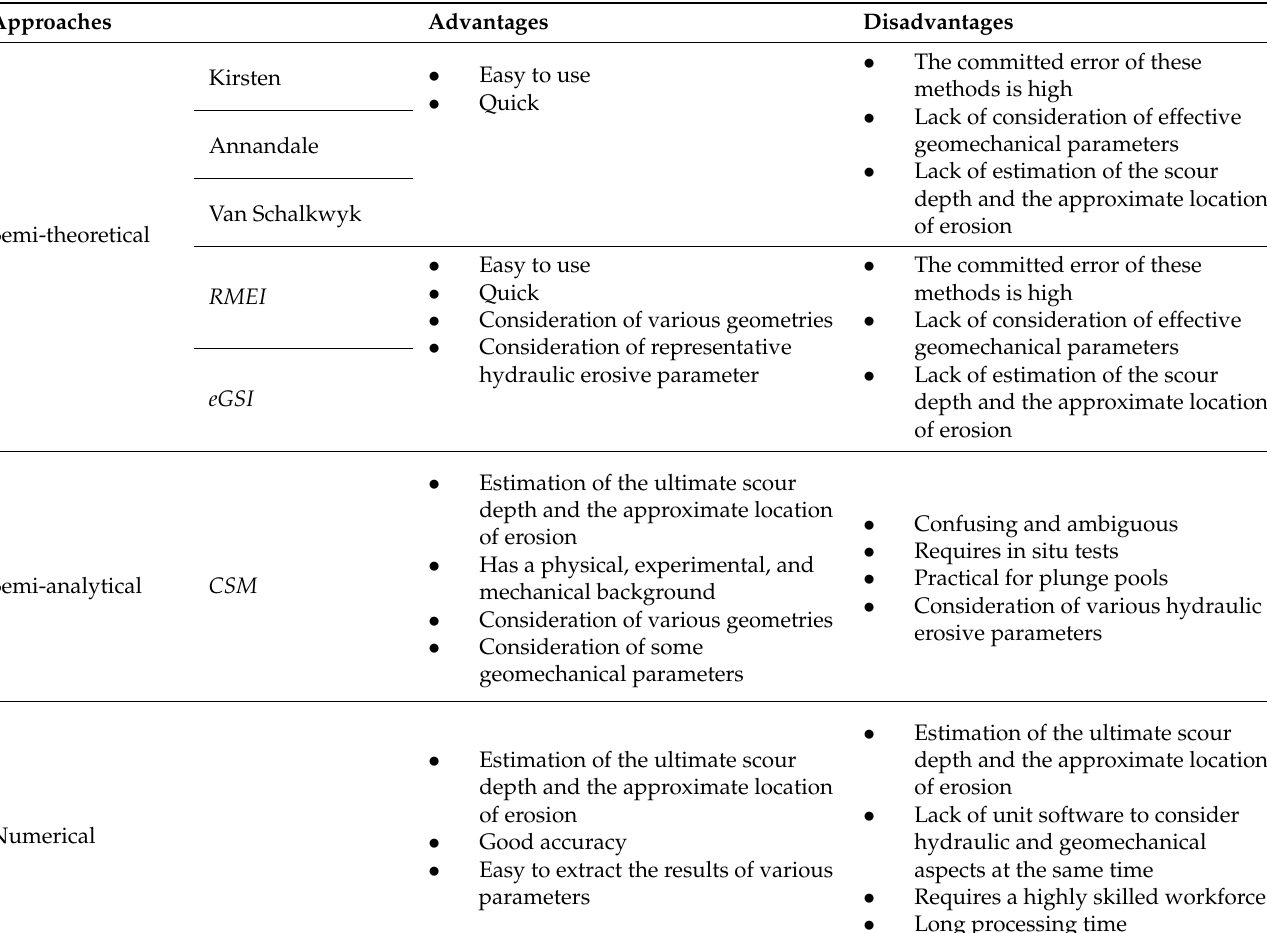
Table 14. Advantages and disadvantages of the various